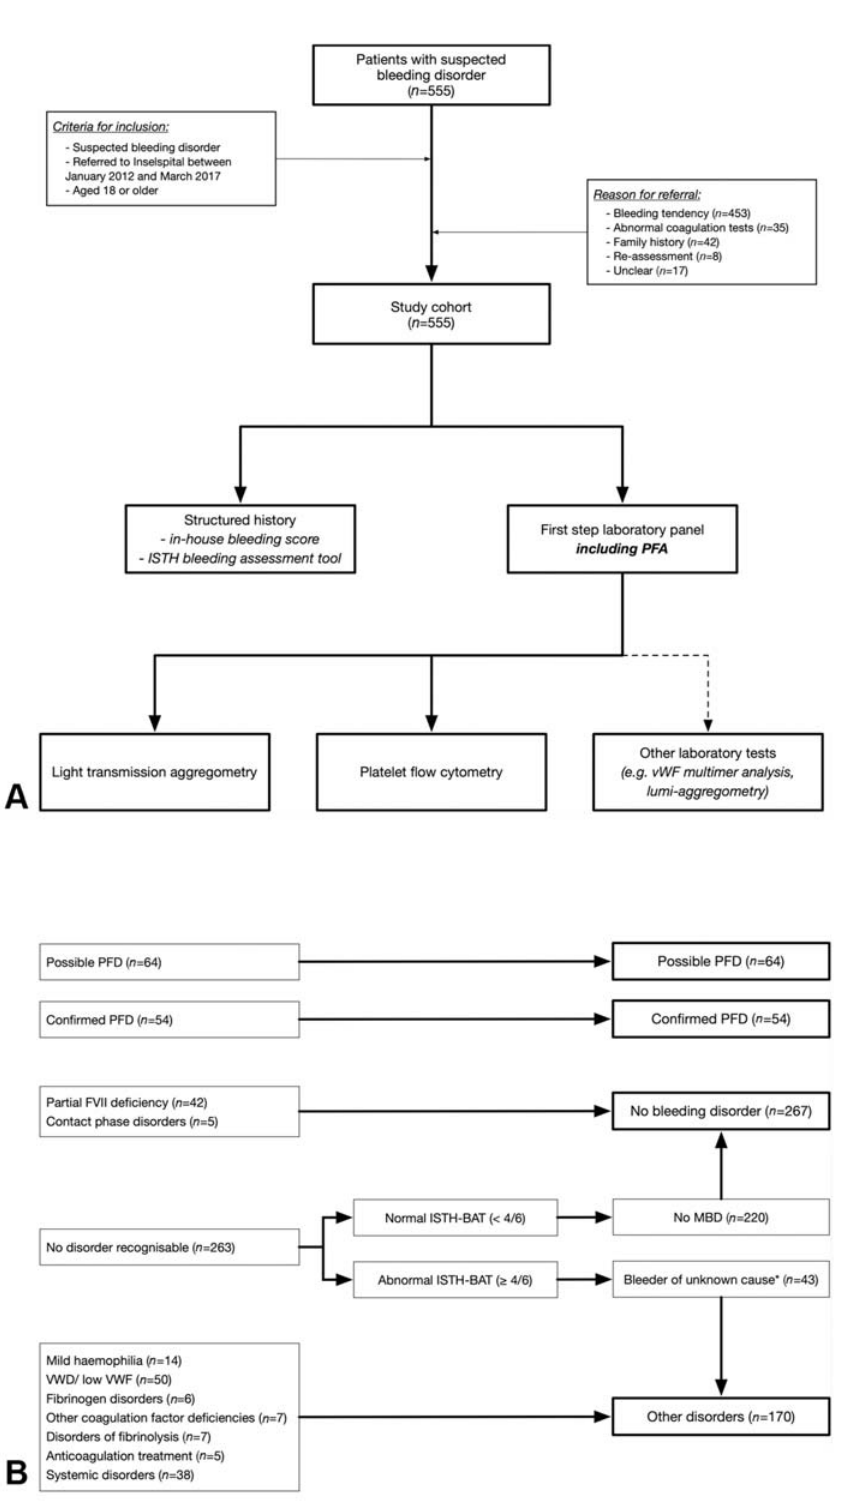
Fig. 1 ( A ) Patient fl ow. In a prospective cohort study, we collected clinical characteristics and laboratory data from all consecutive patients referred between January 2012 and March 2017 to an outpatient unit of a university hospital with a suspected bleeding disorder. The diagnostic work-up was performed following current guidelines and platelet function was tested using light transmission aggregometry as well as fl ow cytometry. ( B ) Classi fi cation of patients according to diagnosis. PFD, platelet function disorder; MBD, mild bleeding disorder; VWD, von Willebrand disease; VWF, von Willebrand factor; FVII, factor